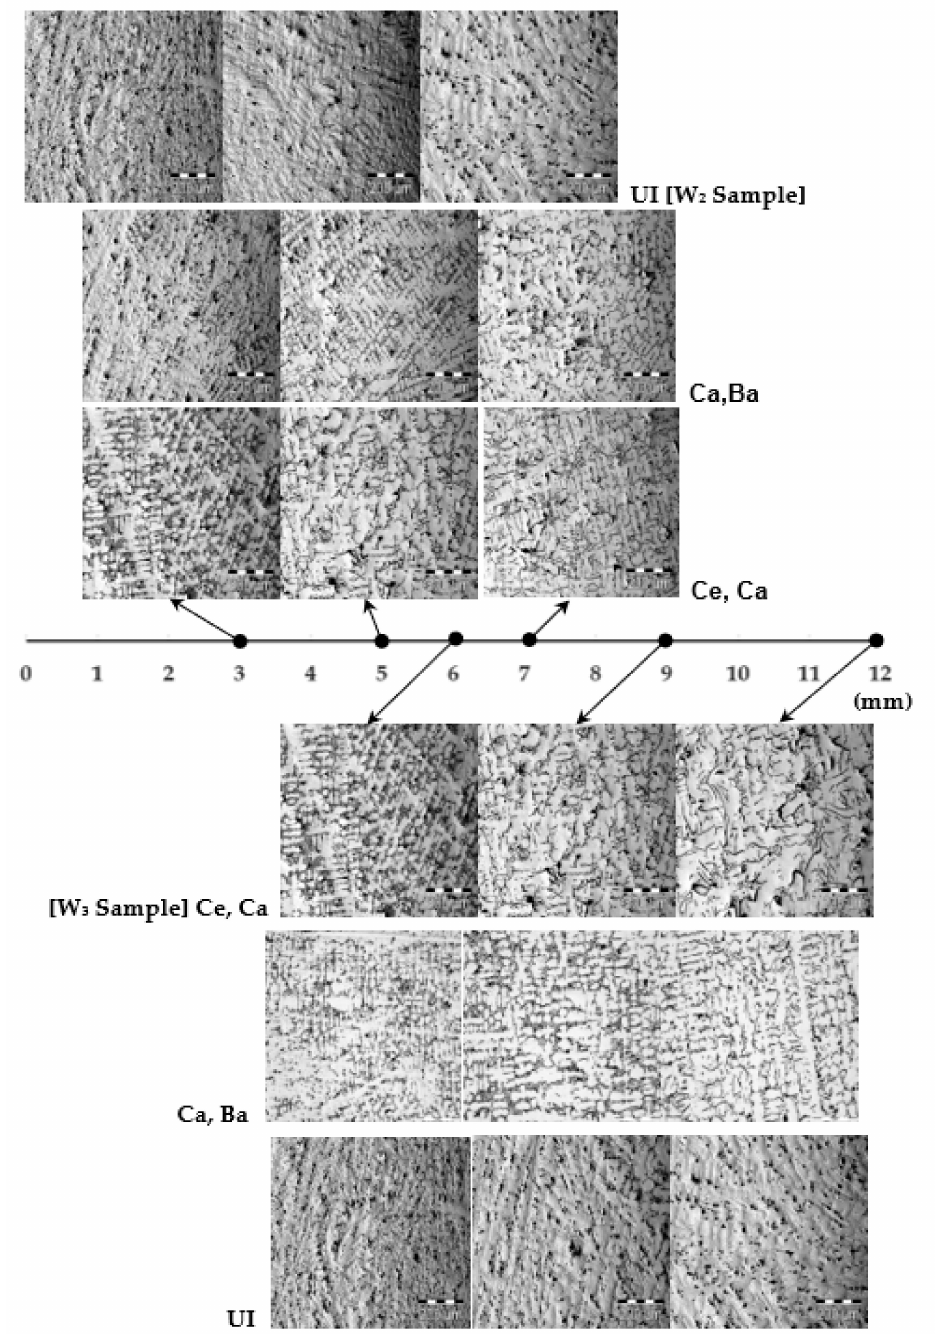
Figure 6. Influence of 0.25 (wt.%) inoculation on the graphite characteristics at different wedge widths of W 2 and W 3 wedge samples (ASTM A 367) (un-etched) and lower free carbides occurrence, respectively. As expected, the increasing of the inoculant addition rate led to higher graphitizing power, but this depended on the inoculant